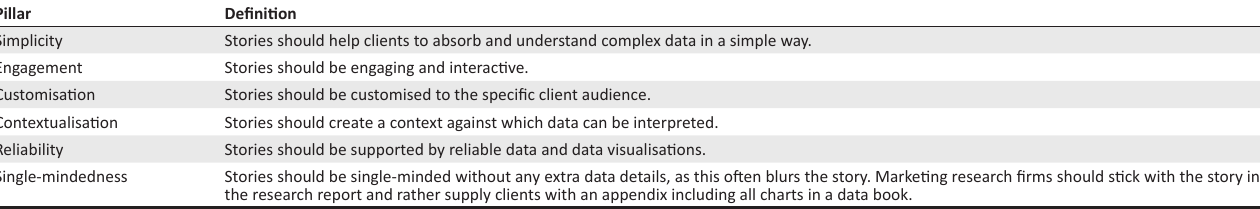
TABLE 1: Pillars of successful